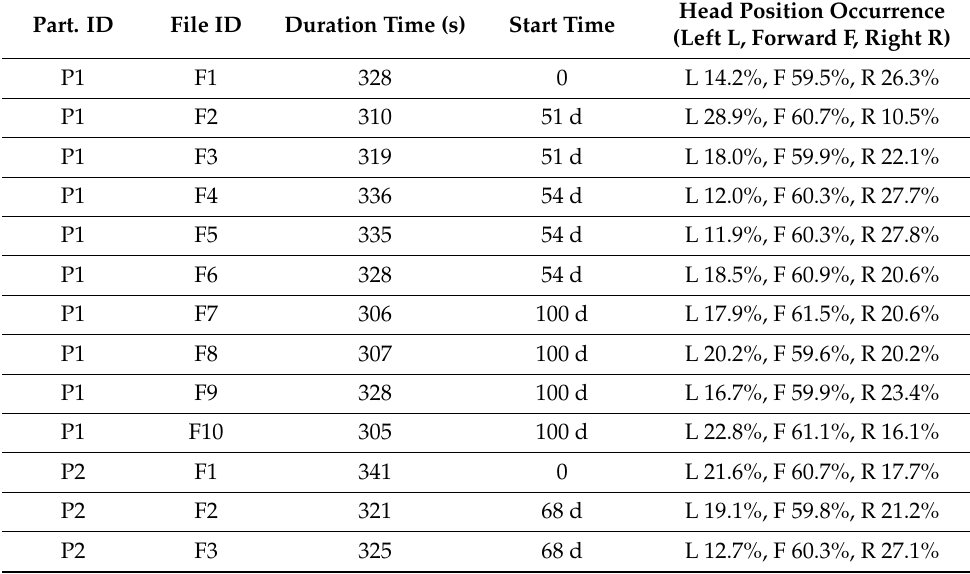
Table 1. The files used to identify the function f . Part.